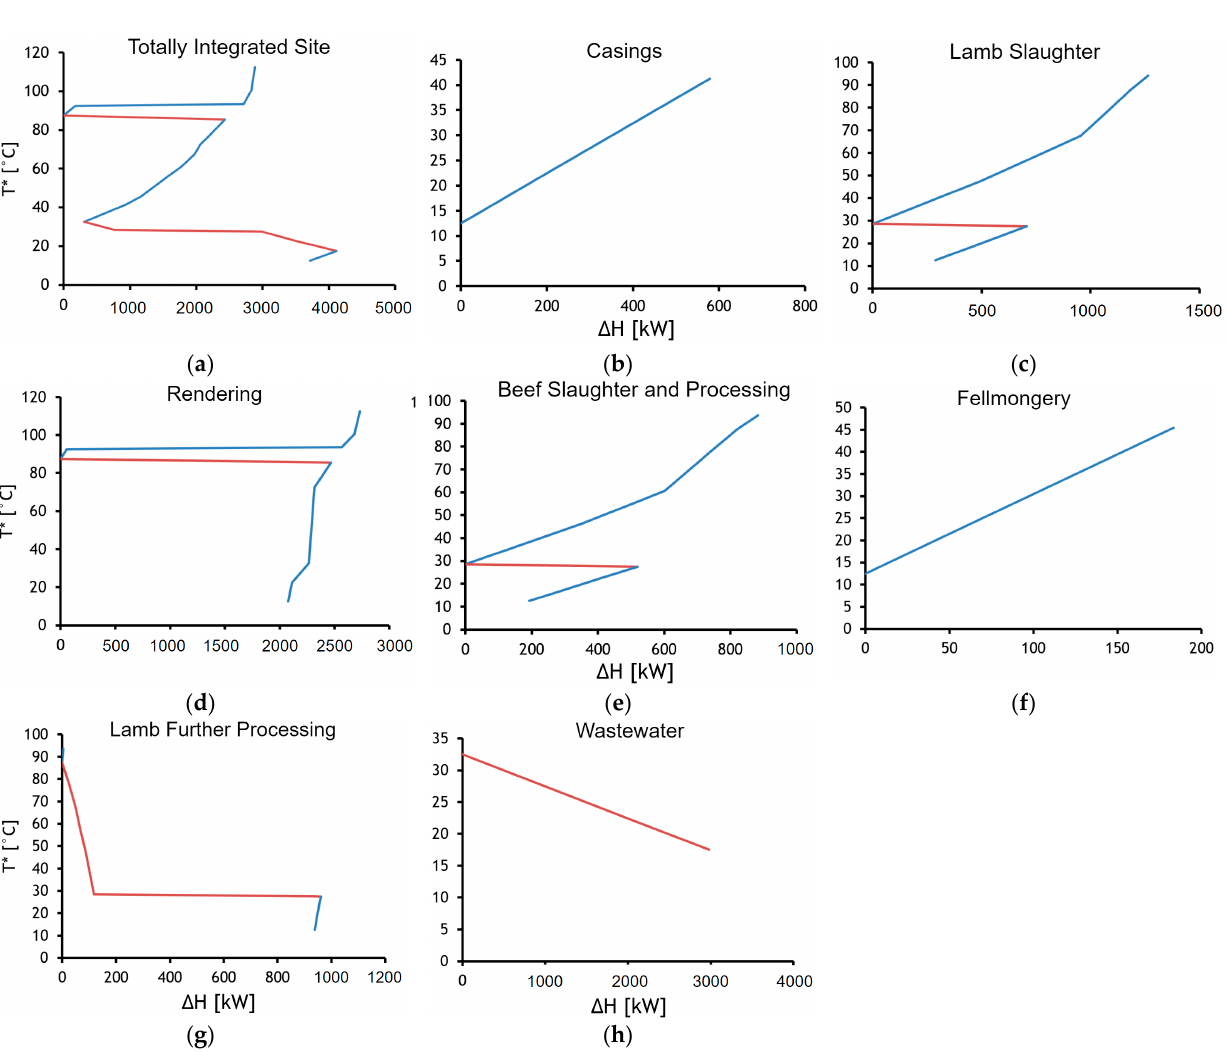
Figure 4. ( a ) Grand Composite Curve for the entire site; ( b ) Grand Composite Curve for the Casings zone; ( c ) Grand Composite Curve for the Lamb slaughter zone; ( d ) Grand Composite Curve for the Rendering zone; ( e ) Grand Composite Curve for the Beef processing zone; ( f ) Grand Composite Curve for the Fellmongery zone; ( g ) Grand Composite Curve for the Lamb Further Processing zone; and ( h ) Grand Composite Curve for the Wastewater zone. Red colored lines represent streams that require cooling, and blue colored lines represent streams that need heating. T* referring to the shifted temperature.